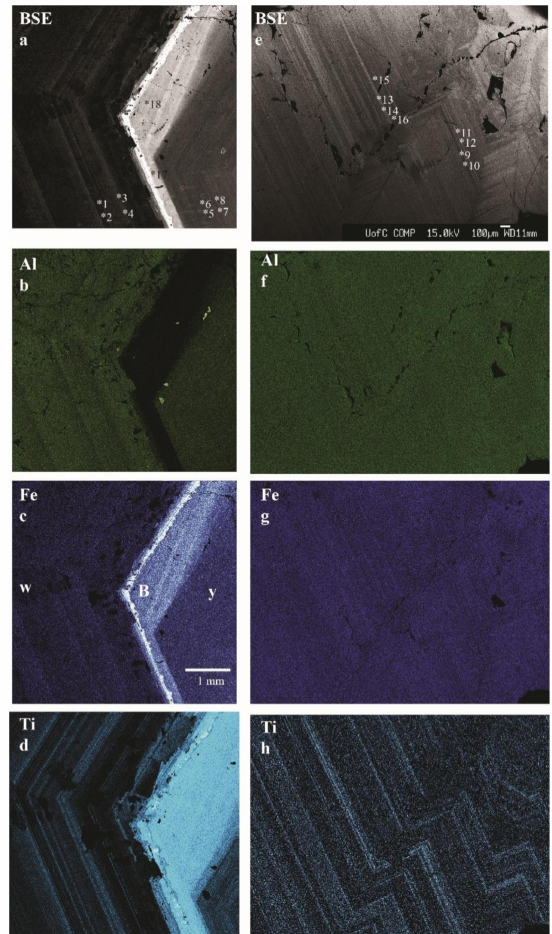
Figure 8. BSE images and elemental maps from two areas of sample-5 from Chihuahua-w, -y, and B (boundary between w and y), Mexico, are shown. The different parts of the crystal are labelled in ( c ), where the white outer layer of the crystal is indicated by w, the yellow core is indicated by y, and B is the boundary between w and y. Left and right columns represents the two different areas. The left column displays both w and y parts of grossular separated by B, which is andradite. The right column displays only the white outer layer of the crystal. ( a , e ) Backscattered electron (BSE) images and their corresponding elemental maps are shown in their respective columns. ( b , f ) Al content, ( c , g ) Fe content, and ( d , h ) Ti content. Chevron zig-zag features are clearly observed in ( e , h ) because the two cubic phases contain different amounts of Ti atoms. The inverse relation between Fe and Al atoms is contained in the